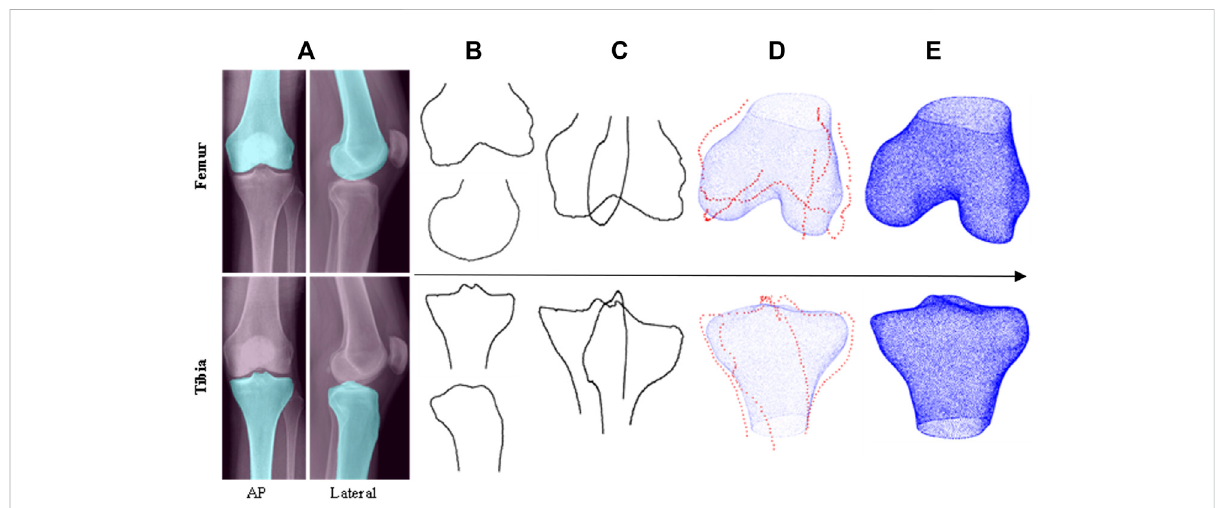
FIGURE 1 Top level work fl ow of the automatic 2D — 3D reconstruction pipeline (top row – femur, bottom row – tibia): (A) CNN segmentation of input X-rays, (B) extracted bone contours, (C) contours aligned in 3D space, (D) PDMs used to transform contours into sparse point clouds which are then fi tted to base shapes of SSMs, (E) 3D model predictions.